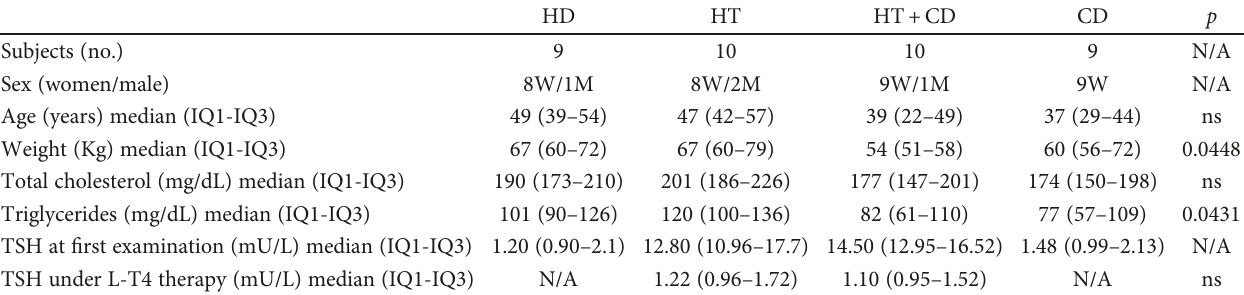
Table 1: Anthropometric and biochemical characteristics of